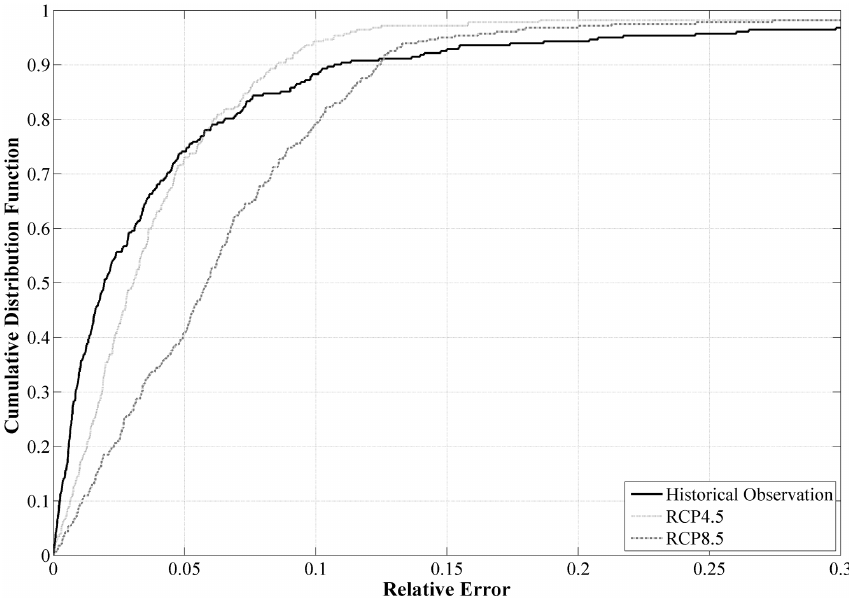
Figure 11. Cumulative distribution function of the relative error of attribution method in three